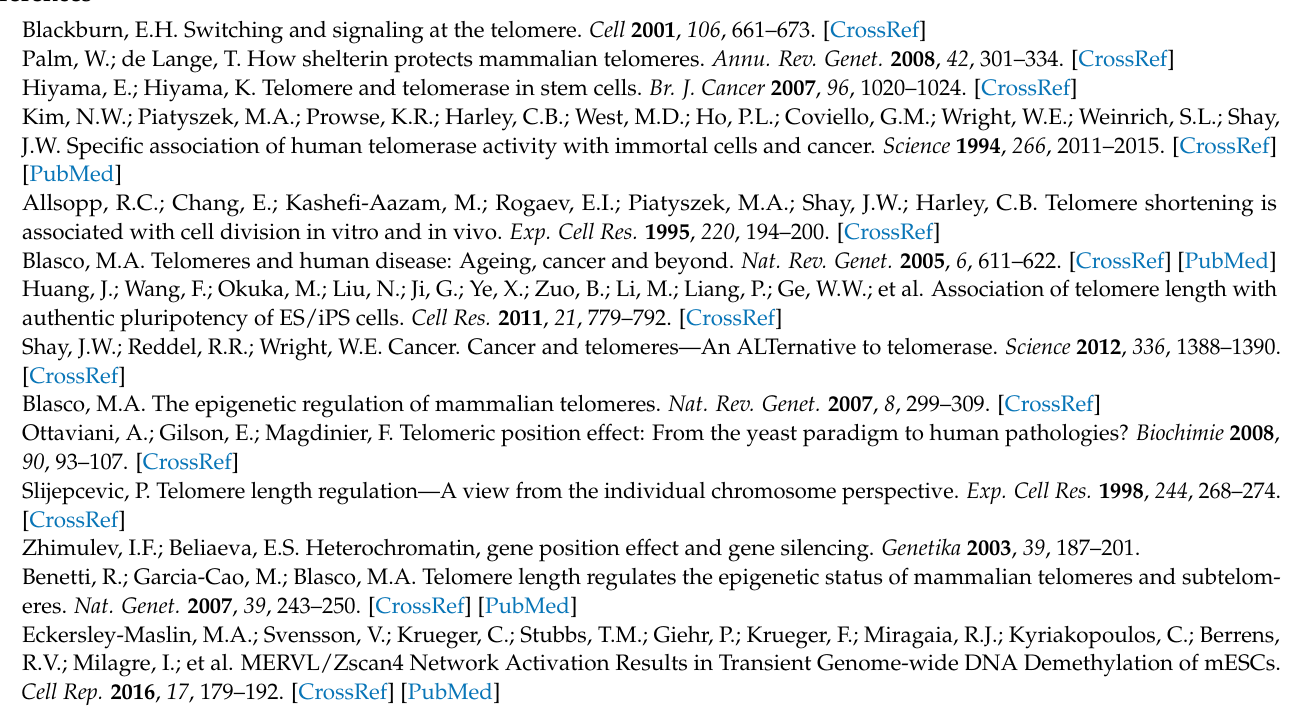
Table S3: Primers used for real-time PCR analysis, Table S4: ChIP-qPCR primers of proximal regions of mouse Zscan4c promoter and human ZSCAN4